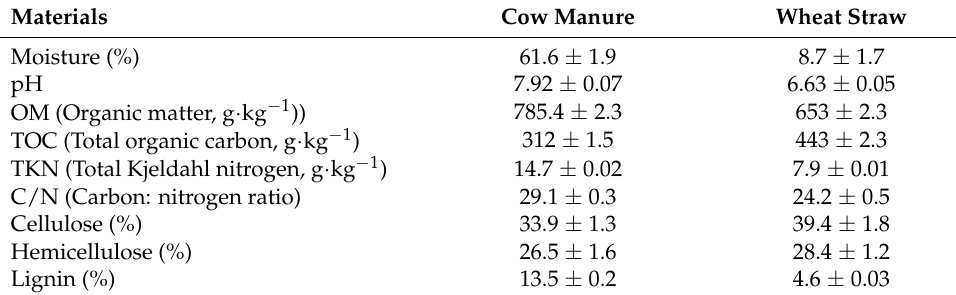
Table 1. Chemical constituents of the agricultural